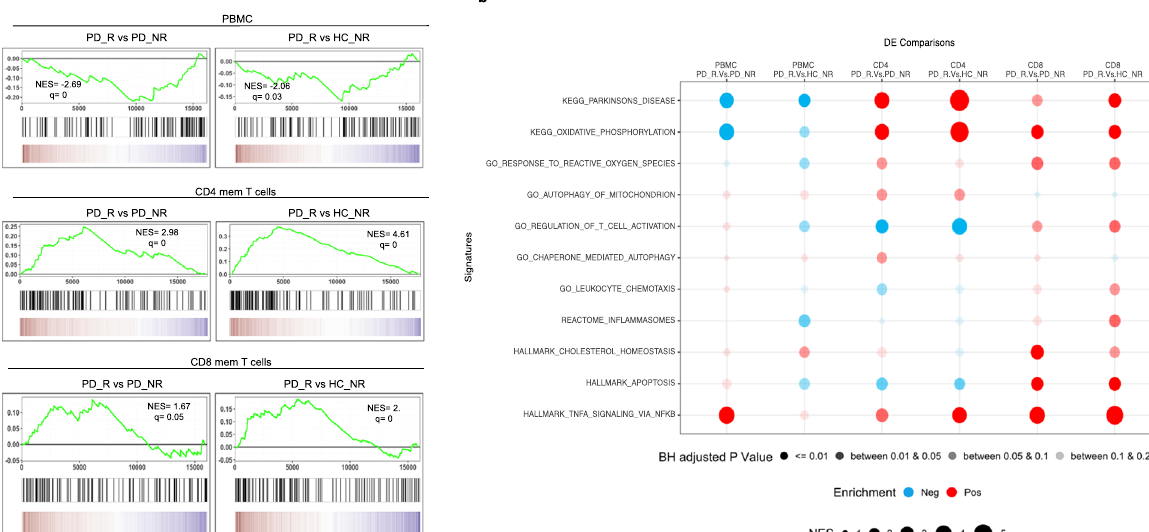
Fig. 3 GSEA of the protein-coding transcriptome of PD_R vs. PD_NR and PD_R vs. HC_NR reveals enrichment of PD-associated gene signature in CD4 and CD8 memory T cells. a GSEA for the KEGG PD gene set. The y -axis of the plot shows the enrichment score (ES) for the gene set as the analysis moves down the ranked list of genes. The direction of the peak shows the degree to which the gene set is represented at the top or bottom of the ranked list of genes. The black bars on the x -axis show where the genes in the ranked list appear. The red portion at the bottom shows genes upregulated in PD_R and the blue portions represent the genes downregulated in PD_R (upregulated in HC_NR or PD_NR). q false discovery rate, NES normalized enrichment score. b Bubble plot demonstrating the enrichment status of several pathways previously reported to be implicated in PD. The red bubble indicates positive enrichment and the blue bubble indicates negative enrichment. The size of the bubble is directly proportional to the normalized enrichment score and the color shade of the bubble is proportional to the adjusted p value, where a darker bubble indicates higher signi fi cance than the lighter